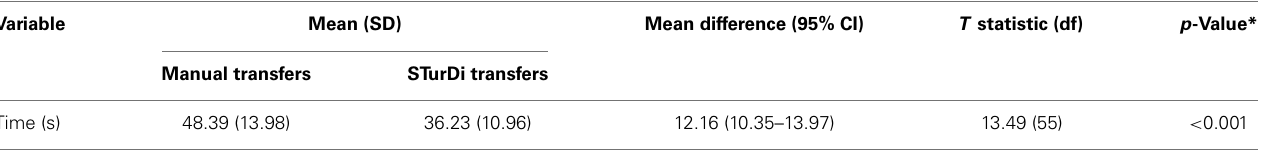
Table 2 | Mean transfer-time for manual transfers and STurDi-assisted transfers .